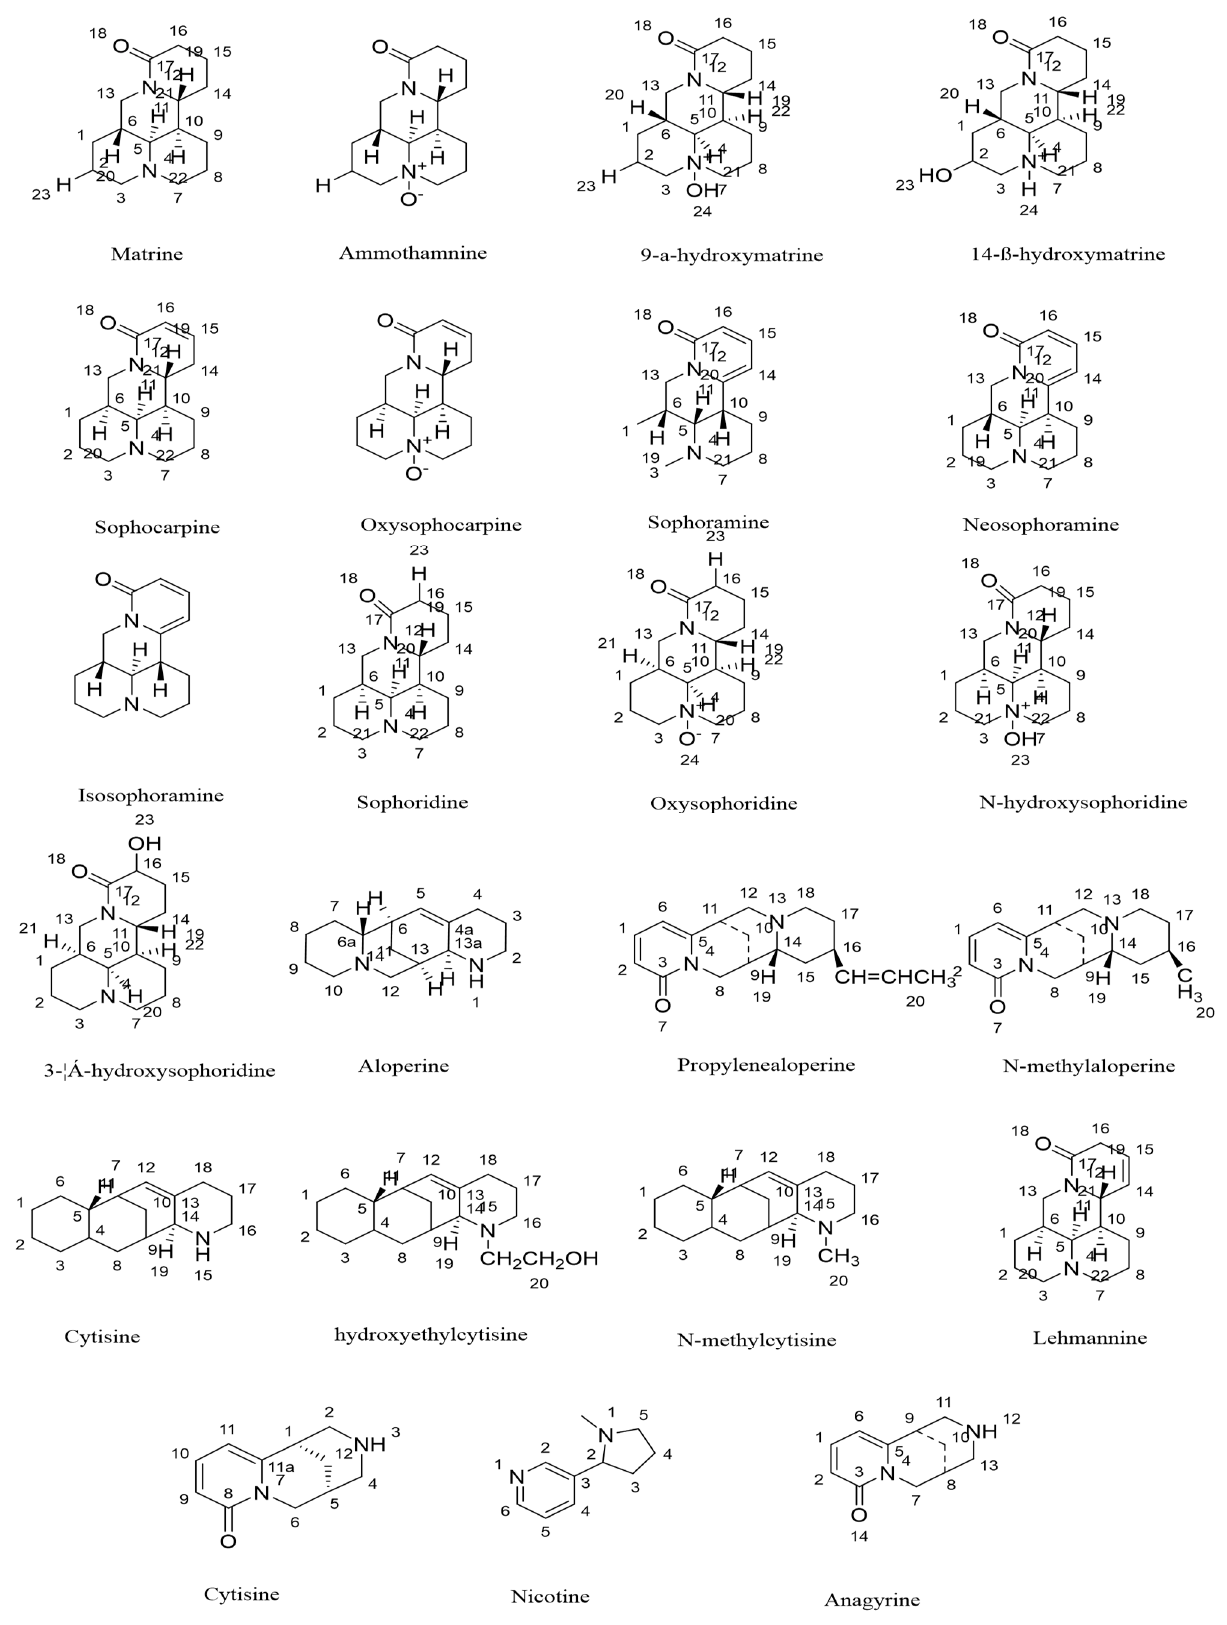
Figure 2. Chemical structure of main alkaloids presents in S. alopecuroides.